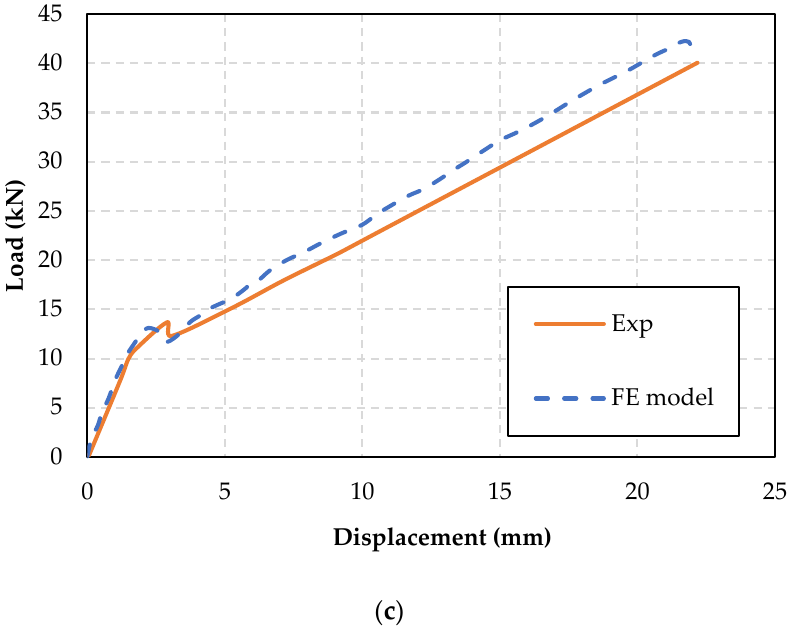
Figure 5. Load-deflection curves from FE model and experimental test [10]: ( a ) Control slab; ( b ) C1; ( c ) C2.